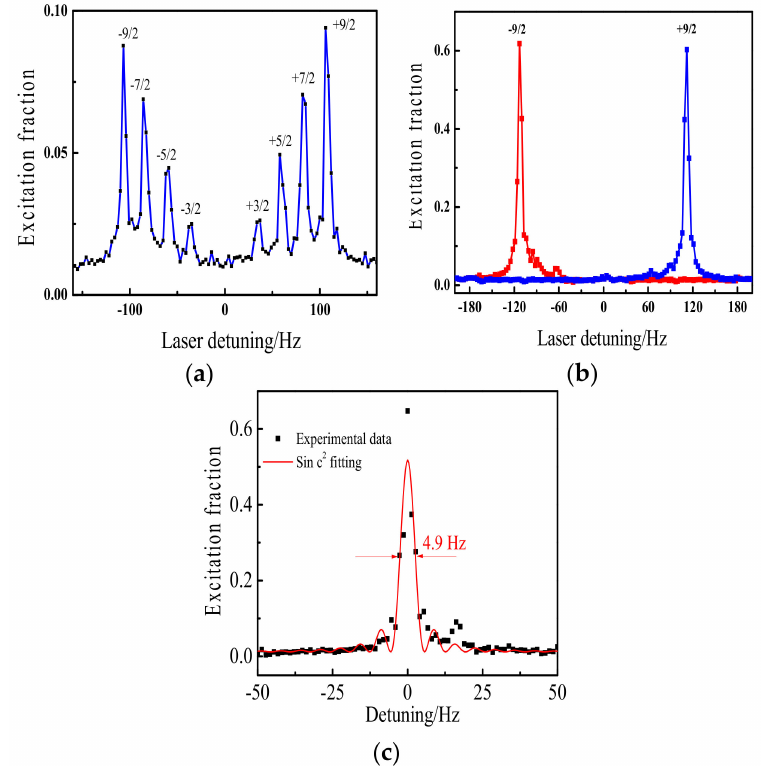
Figure 5. ( a ) Spectra of the π transitions in the presence of a 0.3-G magnetic field; ( b ) Spin-polarized spectra for the transitions m F = +9/2- m F = +9/2 and m F = − 9/2- m F = − 9/2; ( c ) Narrowest linewidth of the magnetic sublevel transitions.